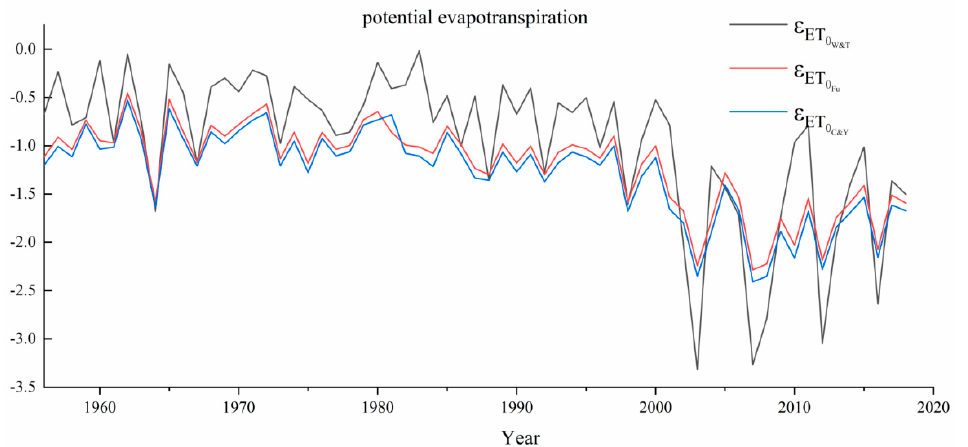
Figure 6. Elasticity coefficients of the potential evapotranspiration for the three Budyko methods from 1956 to 2018.